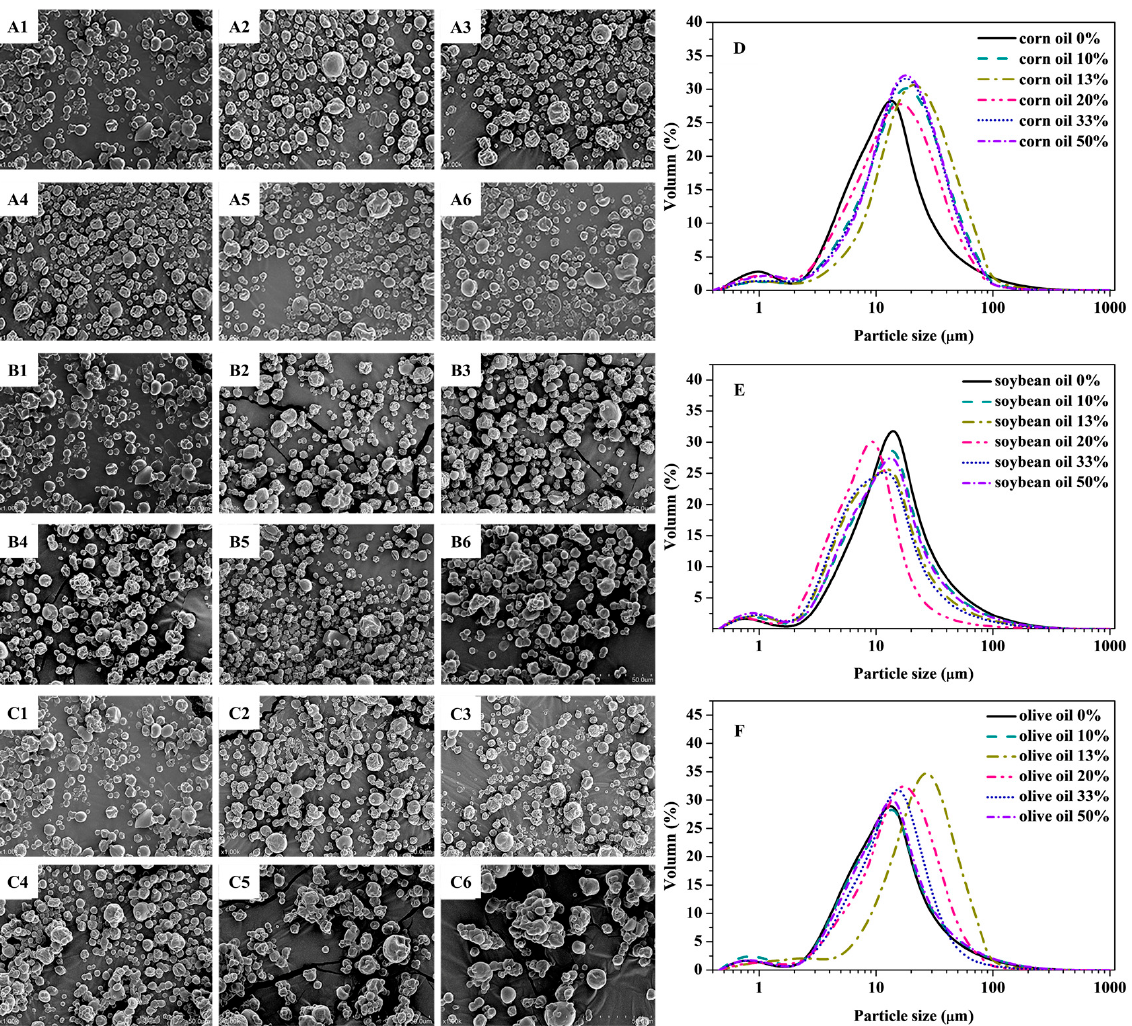
Figure 2. SEM images of GEO microcapsules prepared with different concentrations (0%, 10%, 13%, 20%, 33% and 50%) of CO ( A1 – A6 ), SO ( B1 – B6 ) and OO ( C1 – C6 ). The particle size distribution of GEO microcapsules with different concentrations of CO ( D ), SO ( E ) and OO ( F ).